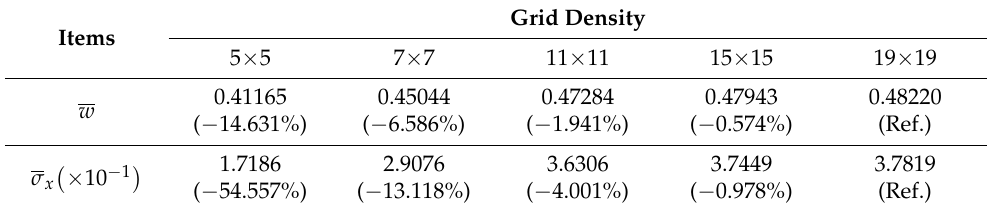
Table 1. Variation in w and σ x with respect to the grid density ( a / h = 10, (3,3,2) hierarchic model). Items